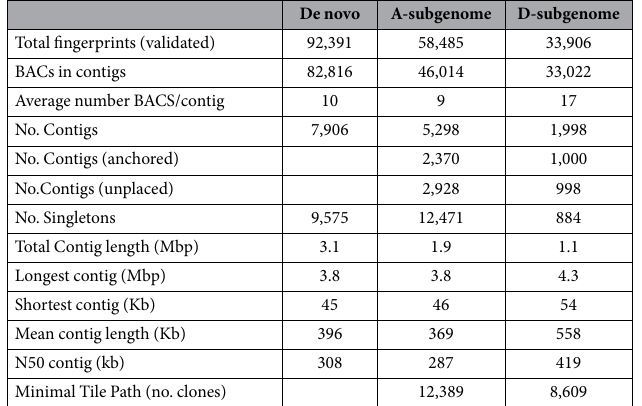
Table 1. De novo physical map assembly